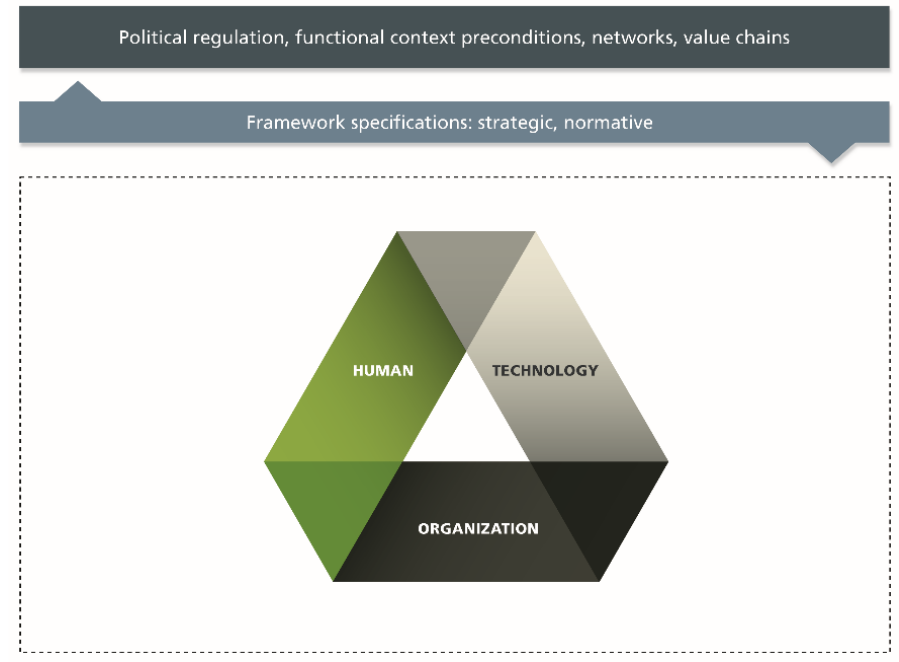
Figure 1. Conceptual representation of the sociotechnical systems approach (own source).